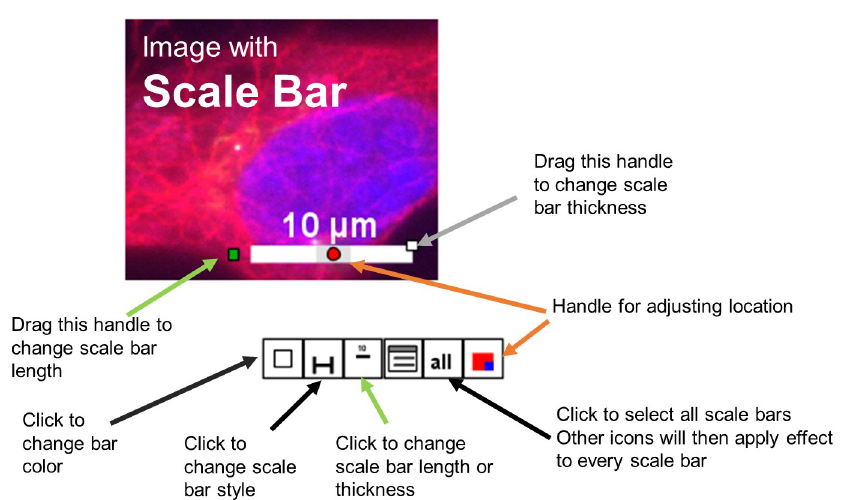
Fig 3. Handles and shortcuts are available when an item is selected. Screenshot shows an example of a selected object. Several icons and handles are visible when the object is selected. User may change the length of the scale bar by dragging a handle or clicking an icon for a menu (green arrows). Similarly, the user may fine tune the location of an object with the handles indicated by orange arrows. Other options are also available (black and grey arrows). Descriptions and diagrams for each major object type are shown in user manual.